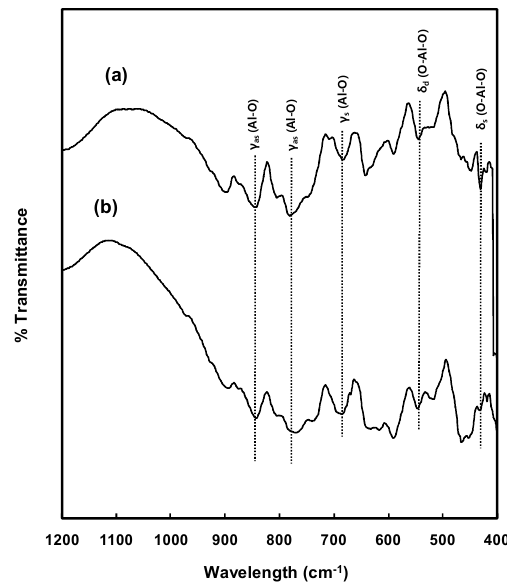
Figure 4. Infrared spectra of the SAOs prepared by ( a ) hydrothermal reaction and ( b ) sol–gel method.